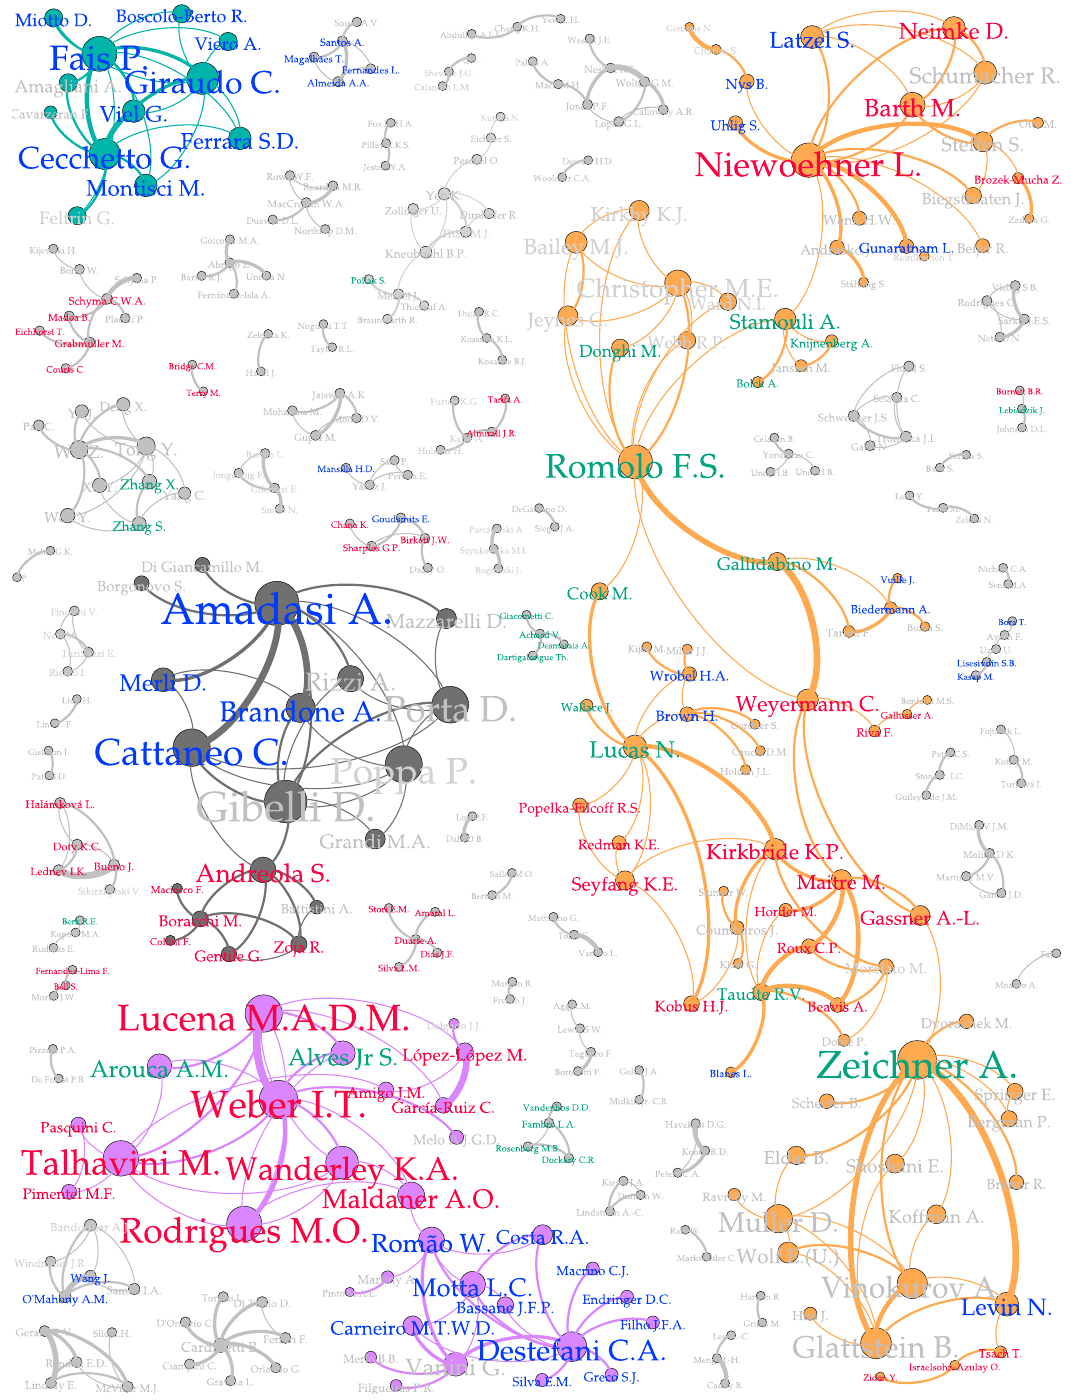
Figure 3. Co-authorship network generated by Gephi and ForceAtlas2 algorithm. Authors who have contributed to more than one publication on gunshot residue were considered, selected using the R code. The nodes represent authors and the edges co-authorship. Eigenvector centrality is used to determine the size of the node. The four largest networks (i.e., group of authors) are in colour. The width of the edge is proportional to the number of contributions between the two authors. The name of the authors who have their last publication in 2016 or later are colour-coded: 2016 in blue, 2017 in green and 2018 in red.